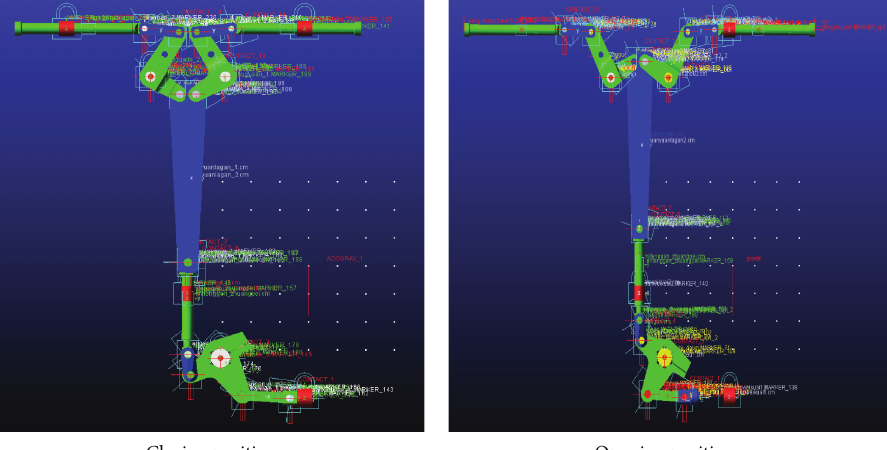
Figure 7: Transmission mechanism modeled in ADAMS.